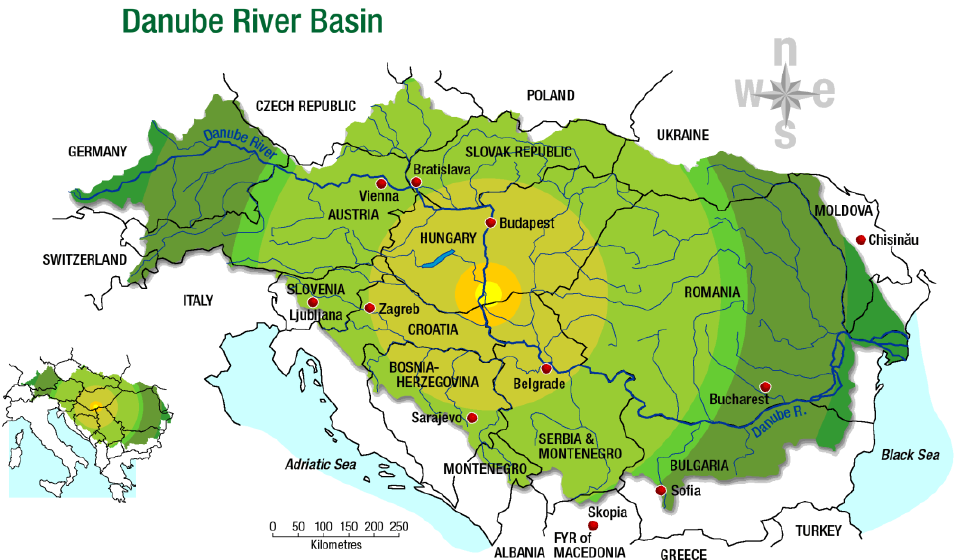
Figure 6. The Danube River Basin, with the Pannonia Plain at its centre, whose climate and relief were unfavourable for the development of culture, under the influence of cold from the north during the Ice Age 10000 years ago. At the transition between the yellow-green and the bright green circle, the culture of Lepenski Vir was created. On this part of the stream, the river was calm, and considerably warmer than in the north, where its tributaries were cold rivers from the Tatras and the Carpathian Mountains.